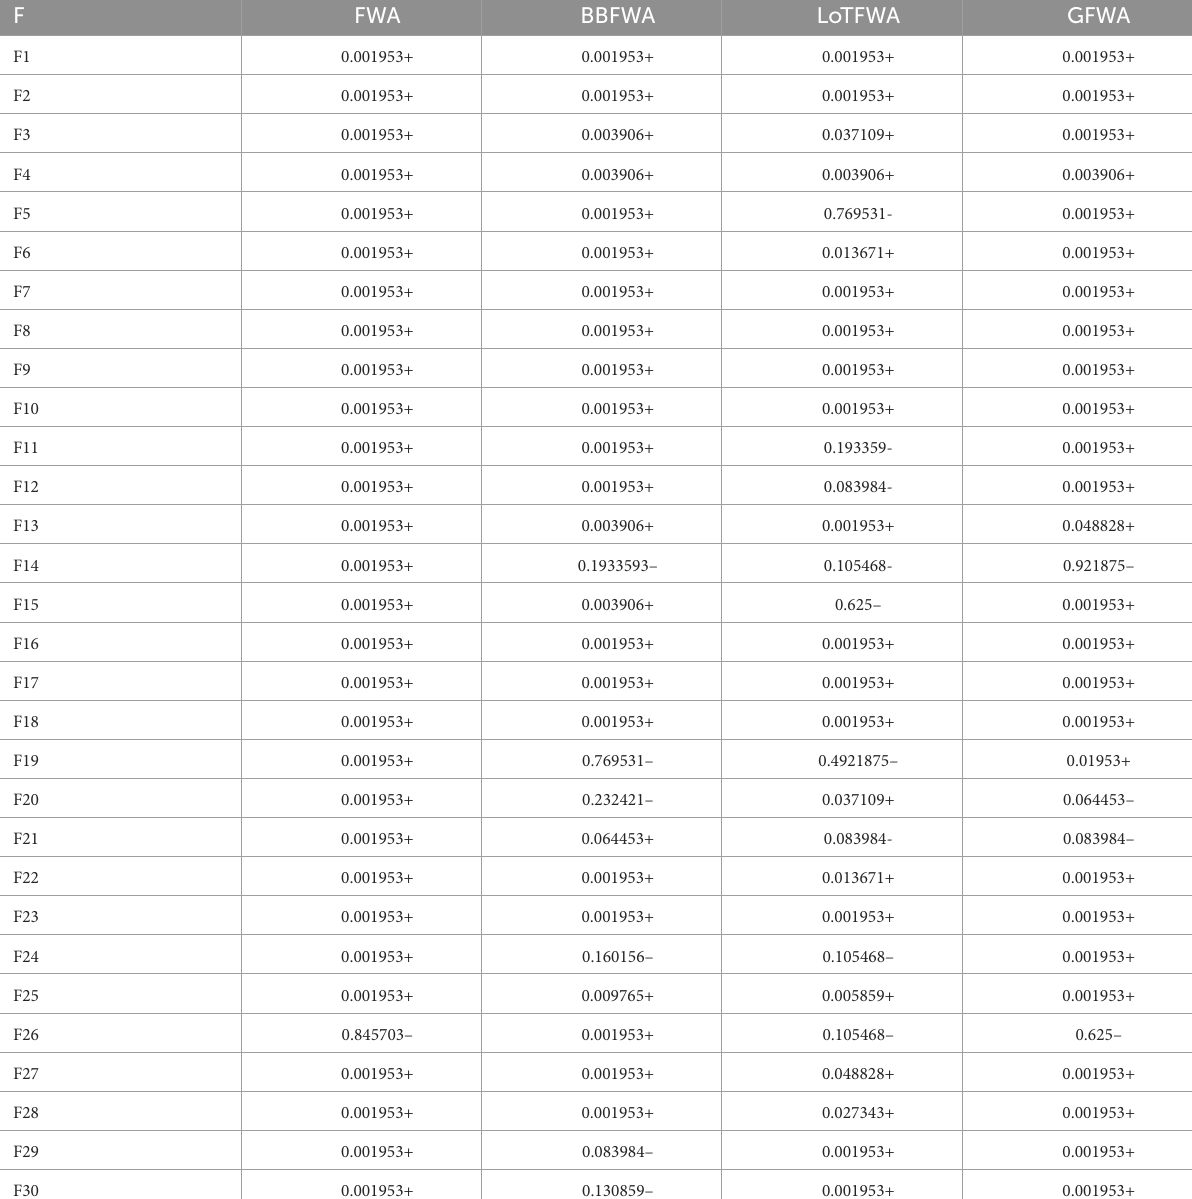
TABLE 7 The calculated p-values for FWHHO vs. fireworks algorithms. F